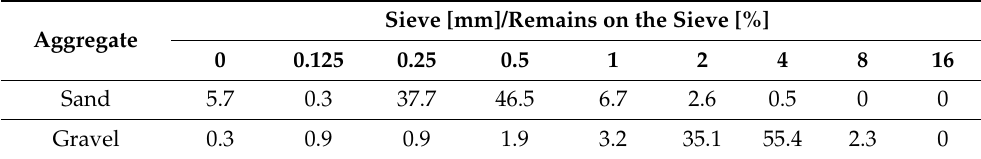
Table 2. Chemical compositions of the aggregate